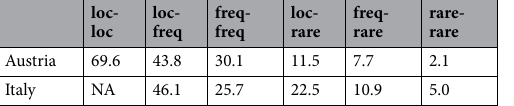
Table 2. For both study sites (Austria, Italy) the mean percentage of co-occurrence between individuals of different classes is shown: locals (loc), frequent visitors (freq), rare visitors (rare). Data refer to the time between marking and their last observation.